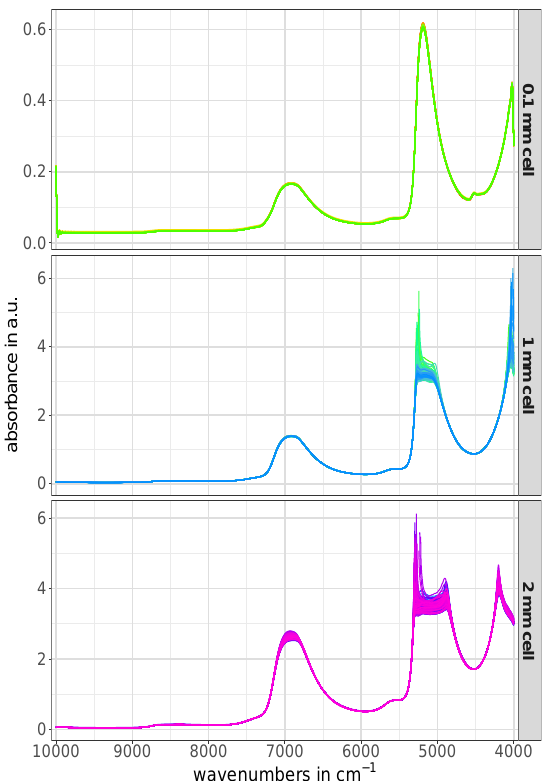
Figure 2. Raw NIR spectra (calibration and test set) of all three utilized cell pathlengths. The spectra were only transformed from transmittance to